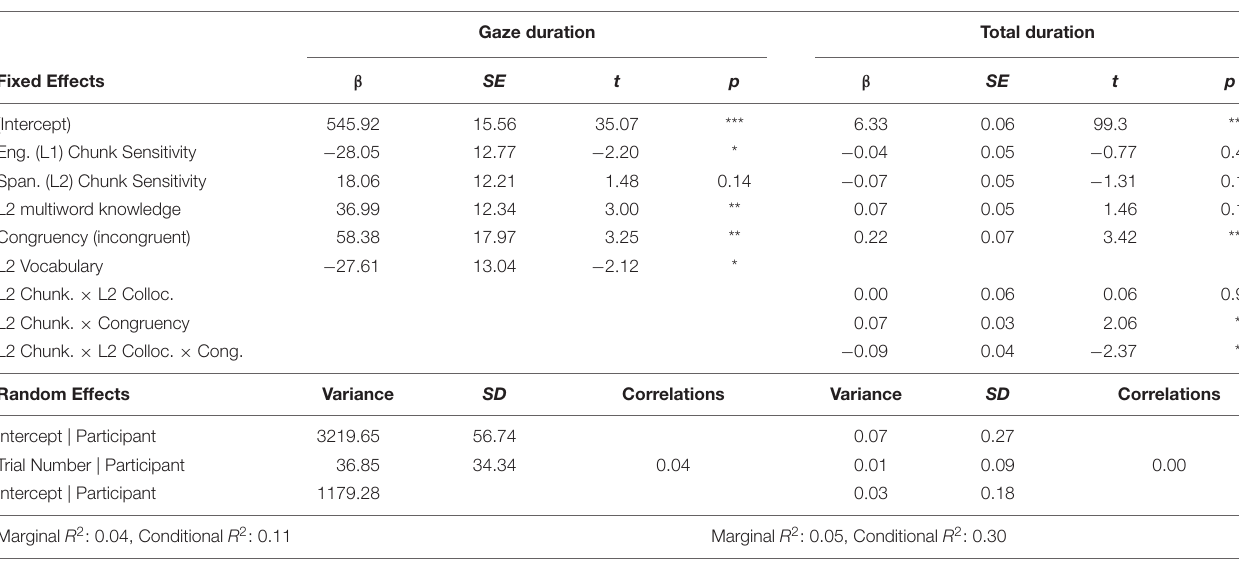
TABLE 4 | Summary of selected models for the verb region.